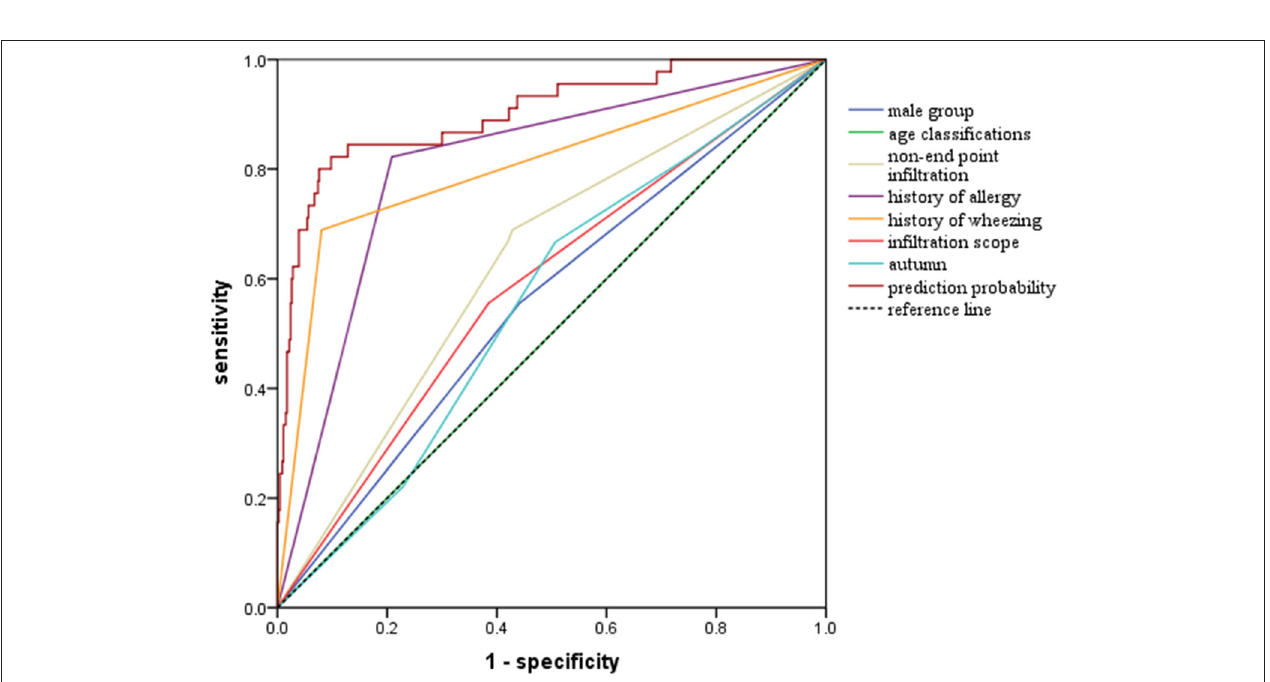
FIGURE 1 | Receiver operator curves (ROC) of multiple logistic regression model and single univariate variable as predictors of wheezing among children with MP